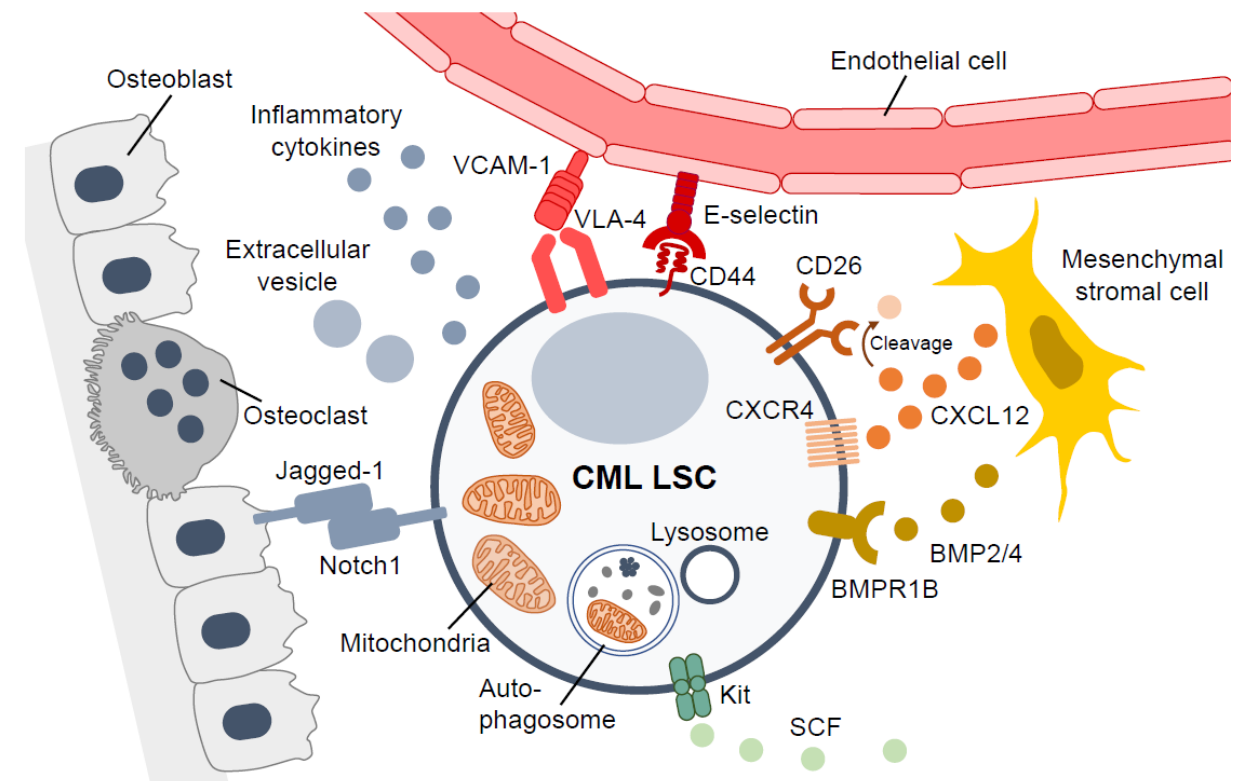
Figure 1. CML leukemic stem cells, and c of the bone marrow microenvironment for CML LSCs. CD26 disrupts the CXCL12/CXCR4 axis by cleaving CXCL12 to promote LSCs’ mobilization into the blood. LSCs bind to VCAM-1 and Selectin on their bone marrow niche. Secretion of LSCs demand a tightly regulated metabolism. BMP2/4 and other chemokines/cytokines through auto- or paracrine mechanisms also support quiescence, cellular growth, and drug resistance of CML LSCs. LSC, leukemia stem cell; VCAM-1, vascular cell adhesion molecule-1; VLA-4, very late antigen 4; CXCL12, C-X-C motif chemokine 12; SCF, stem cell factor; BMP, bone morphogenetic protein.